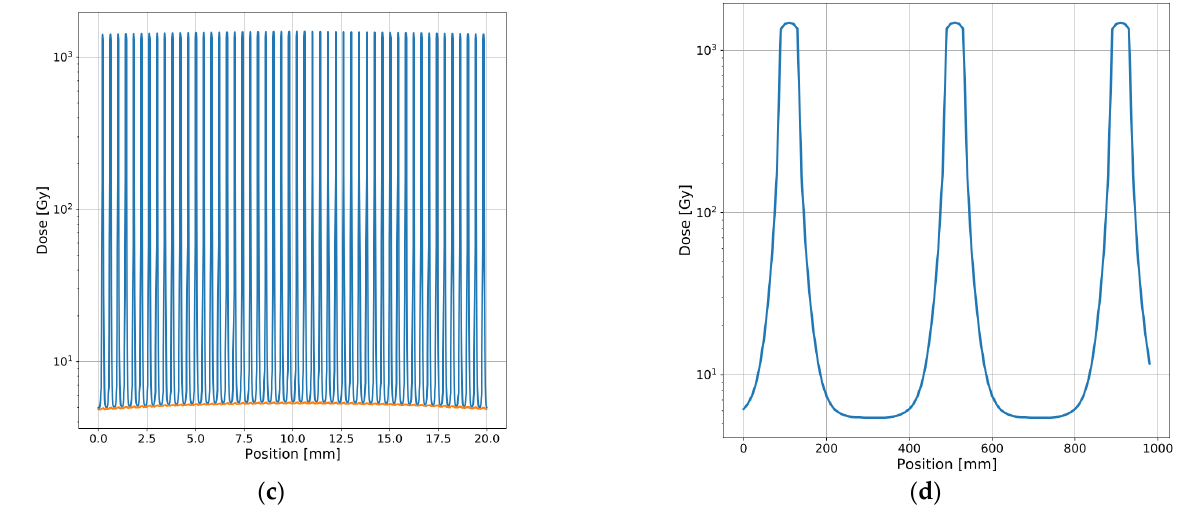
Figure 2. Results from the Monte Carlo simulation for MBI and PBI at a 1 mm depth in water (cell layer of in vitro exposures). Profiles of MBI with a peak dose of 174 Gy ( a , b ). Horizontal ( c ) and diagonal ( d ) profiles of PBI across the field @ 1500 Gy (compare Figure 1).